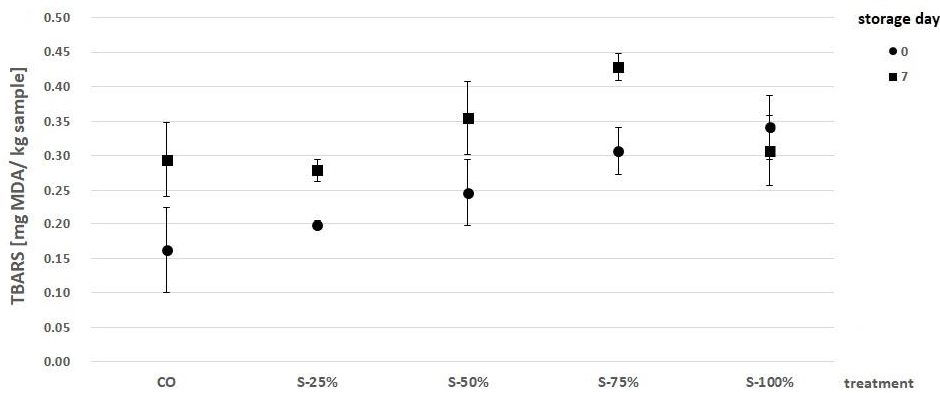
Figure 3. Analysis of lipid oxidation (TBARS) in burgers with substituted fat after 0 and 7 days of storage. CO-control with tallow (0% fat substitute), S-25%, S-50%, S-75%, S-100% means, respectively, replacing beef fat with 25, 50, 75, and 100% substitute .